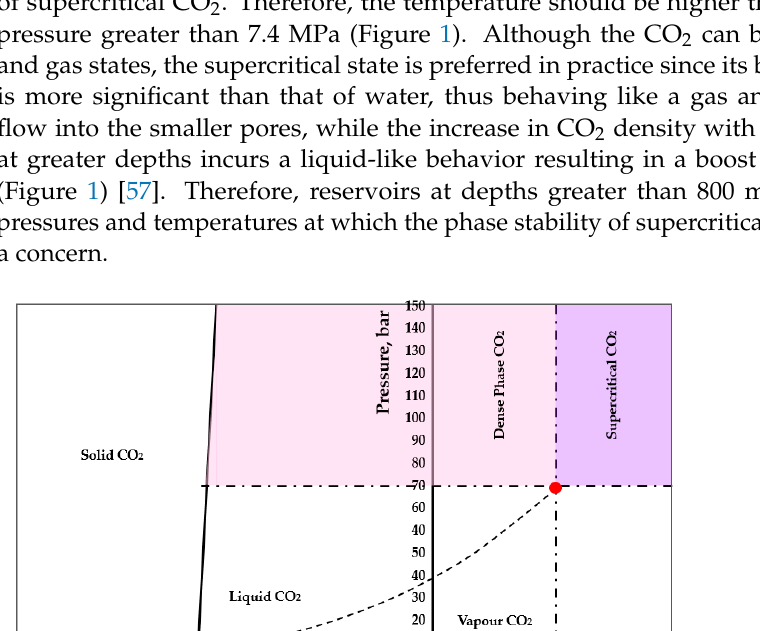
2 (modified after [63]).